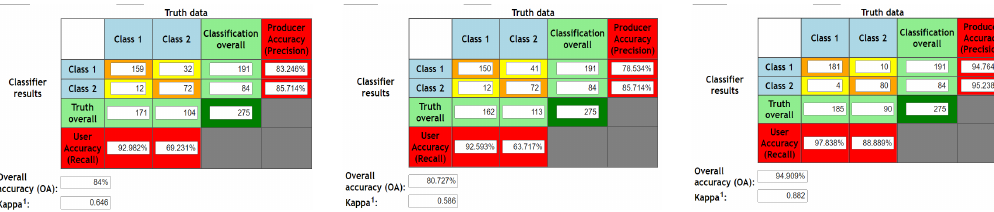
Figure 12. Confusion matrix for 2 fold cross validation of 3D Doppler images for SVM, LSTM and VAE-CNN